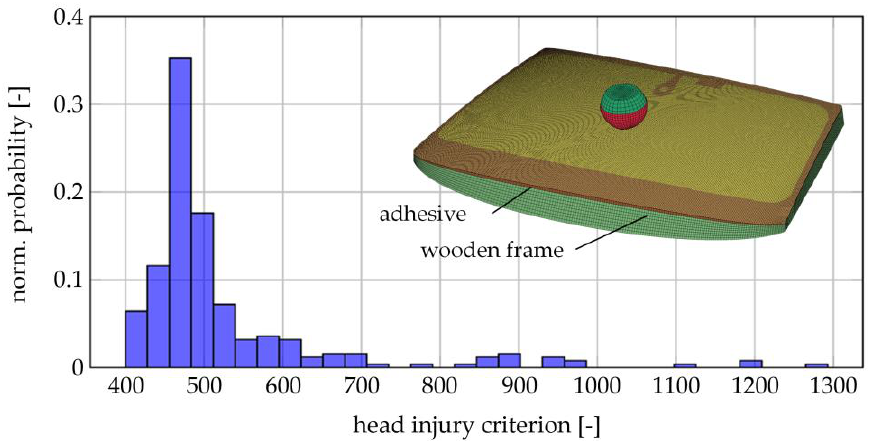
Figure 9. HIC probability for head impact simulations on windshields glued on a wooden frame. 250 HIC values from stochastic simulations are depicted, cf. [11].